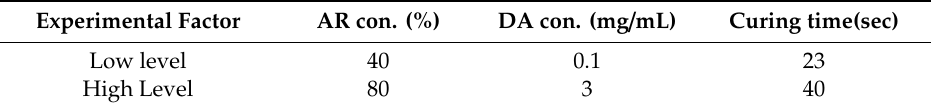
Table 1. Experimental factors and